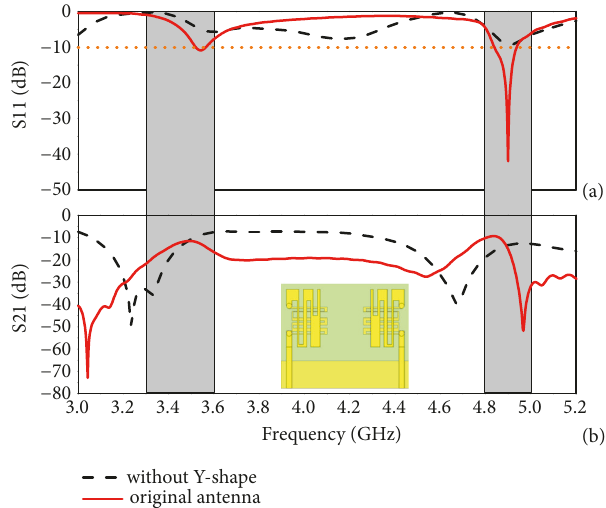
Figure 4: S-parameters with/without Y-shape structure: (a) S11 and (b) S21. Inset: Model of antenna without Y-shape structure.